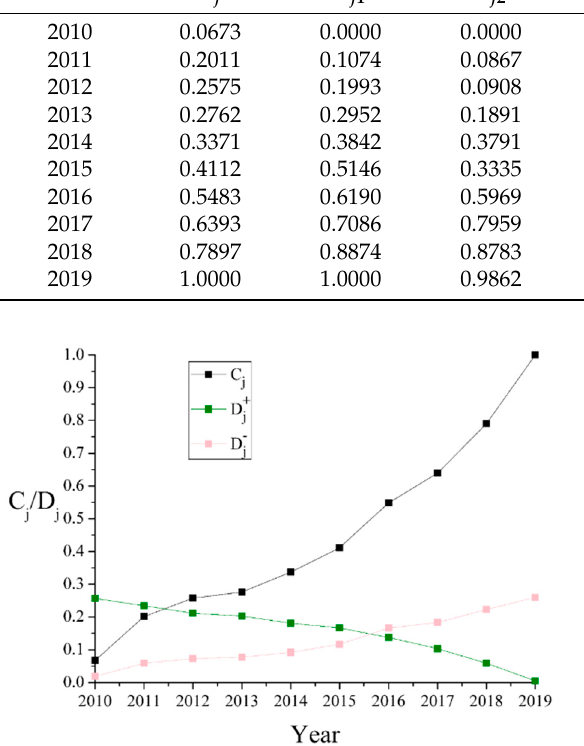
Figure 5. The result of 𝐶 (cid:3037) , 𝐷 (cid:3037)(cid:2878) and 𝐷 (cid:3037)(cid:2879) .